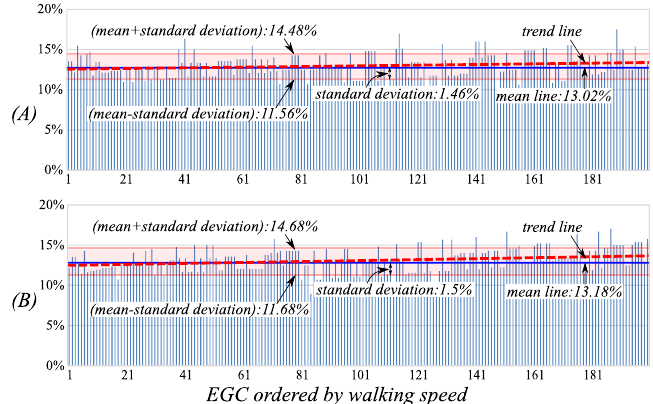
Figure 8. The percentage distributions of the init-LSw ( A ) and init-RSw ( B ) in the cycle during the EGC. The walking speeds of the EGC are gradually increasing along the horizontal